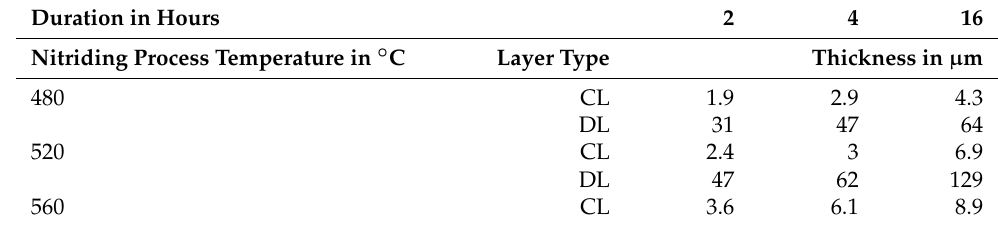
Table 5. Layer thicknesses of the compound and diffusion layers.